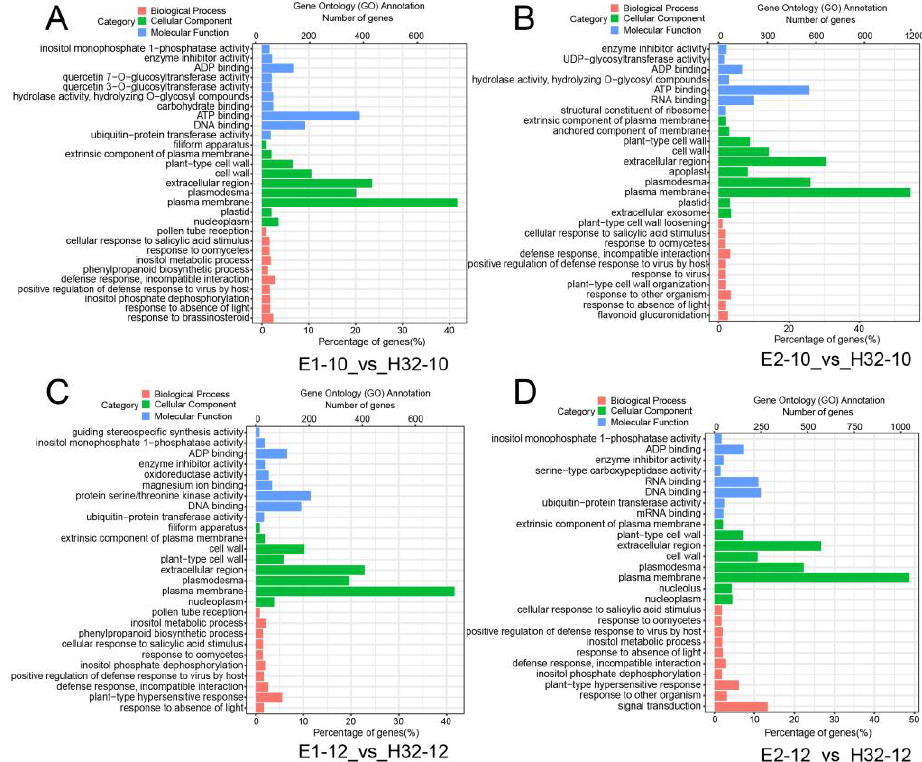
Figure 3. Gene ontology (GO) analysis of DEGs. ( A ) GO map of DEGs in E1-10_vs_H32-10; ( B ) GO map of DEGs in E1-12_vs_H32-12; ( C ) GO map of DEGs in E2-10_vs_H32-10; ( D ) GO map of DEGs in E2-12_vs_H32-12; y-axis represents the GO classification, the bottom and top of the x-axis represent the percentage and number of genes, respectively.